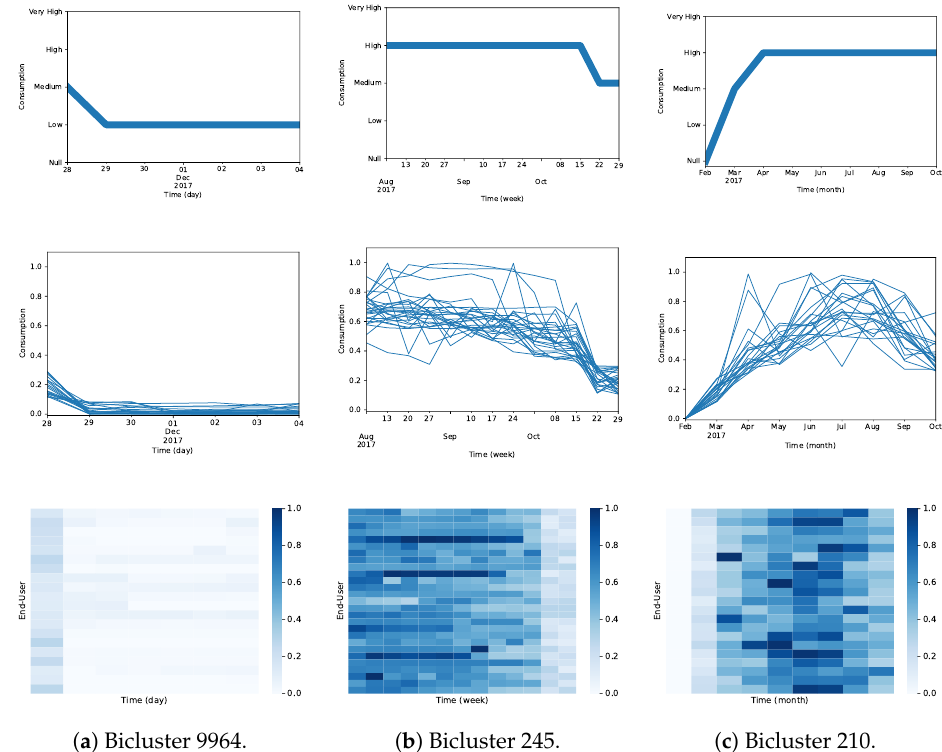
Figure 21. Illustration of the selected constant biclusters (Bicluster 9964, Bicluster 245, and Bicluster 210) found on the daily, weekly and monthly dataset. Consumption patterns on the first row, the user consumption scaled time series on the second row, and the scaled data heatmap on the third row.